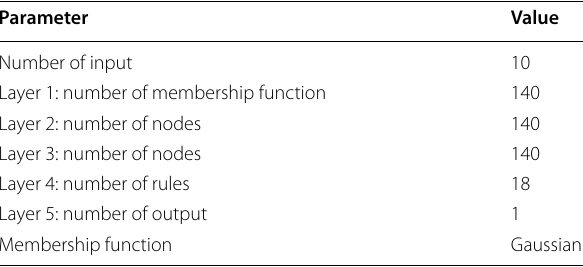
Table 5 The properties of ANFIS structure.